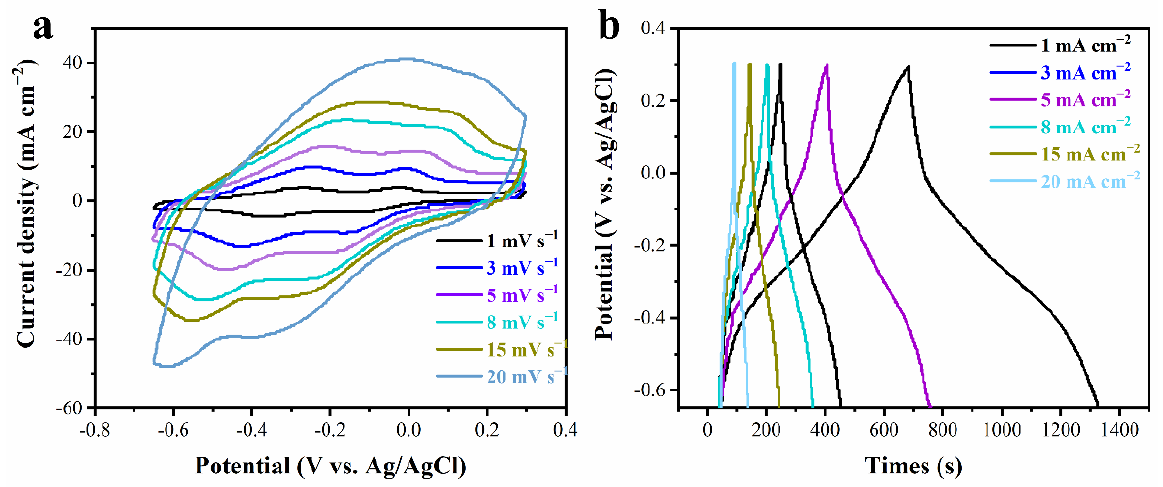
Figure 7. ( a ) CV curves and ( b ) GCD curves.